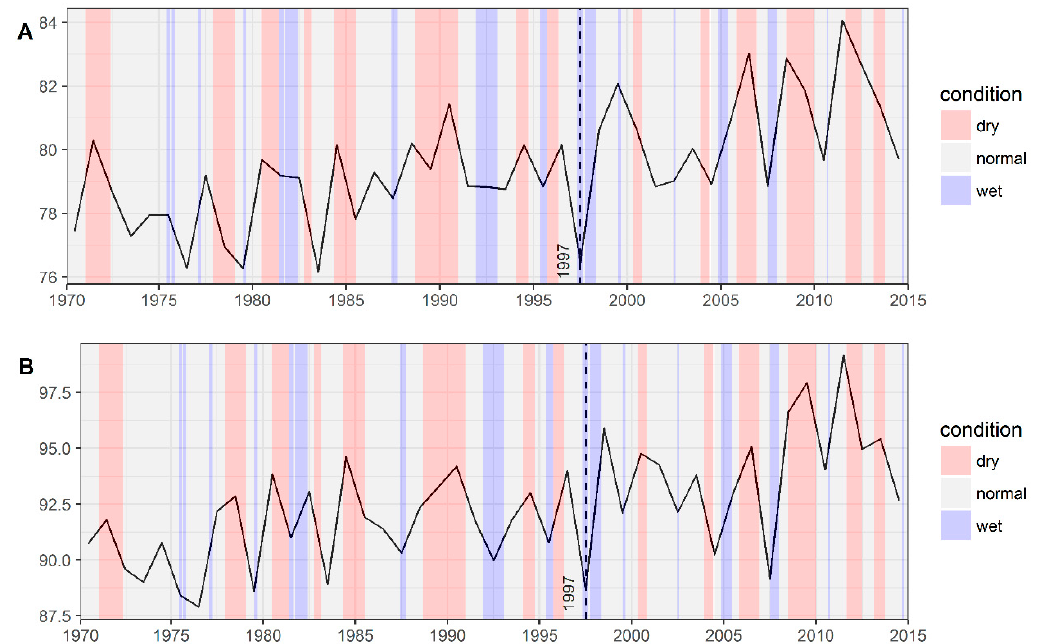
Figure 2. Change points for climate-related indicators overlaid against SPI calculations for periods of dry, normal, and wet conditions: ( A ) mean annual maximum temperature and ( B ) mean maximum summer temperature measured in degrees